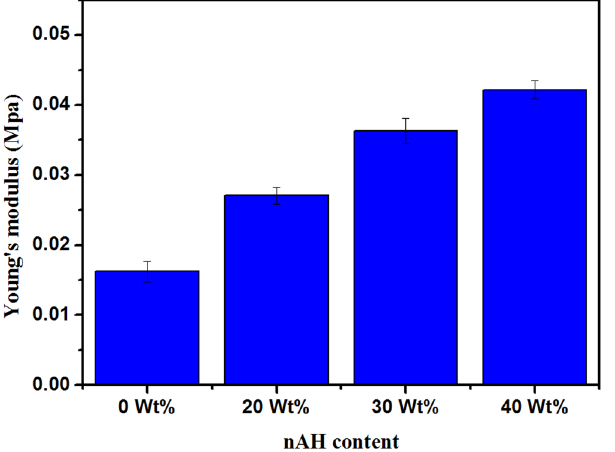
Figure 6. Young’s modulus of Dex-CS/nHA composite scaffolds with different HA contents.